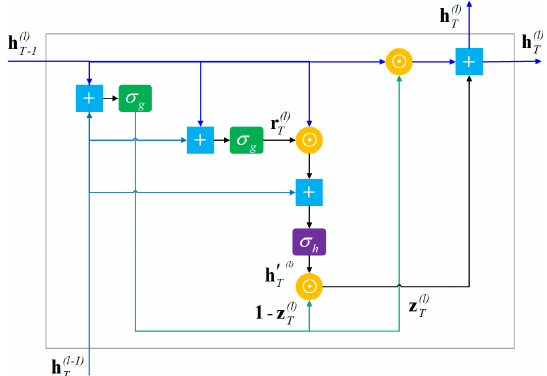
Figure 4. The structure of gated recurrent units (GRU). It consists of a reset gate and an update